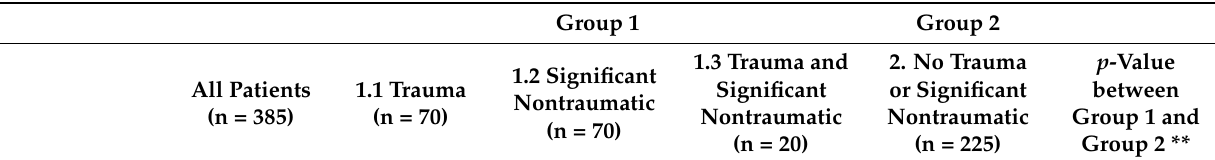
Table 1. Comparison among patients with significant findings (Group 1; trauma, significant nontrau- matic, both traumatic and nontraumatic findings) and those without (Group 2)